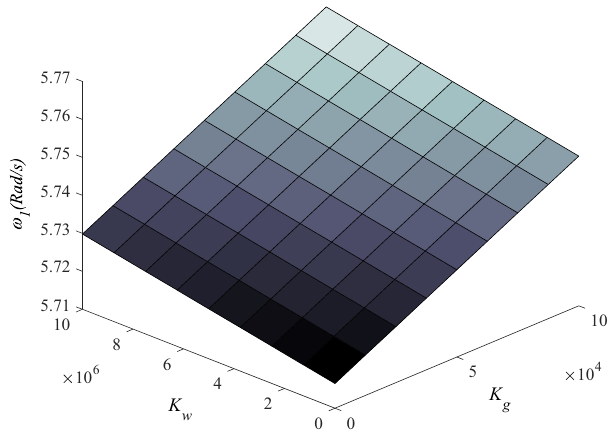
Figure 11: Pasternak foundation parameters ’ e ff ect on the vibration of the cylindrical shell ( h = 0.01 m , h c = 10 h , R = 100 h , L = 20 h , φ r = 2 π , and μ P = 2 )